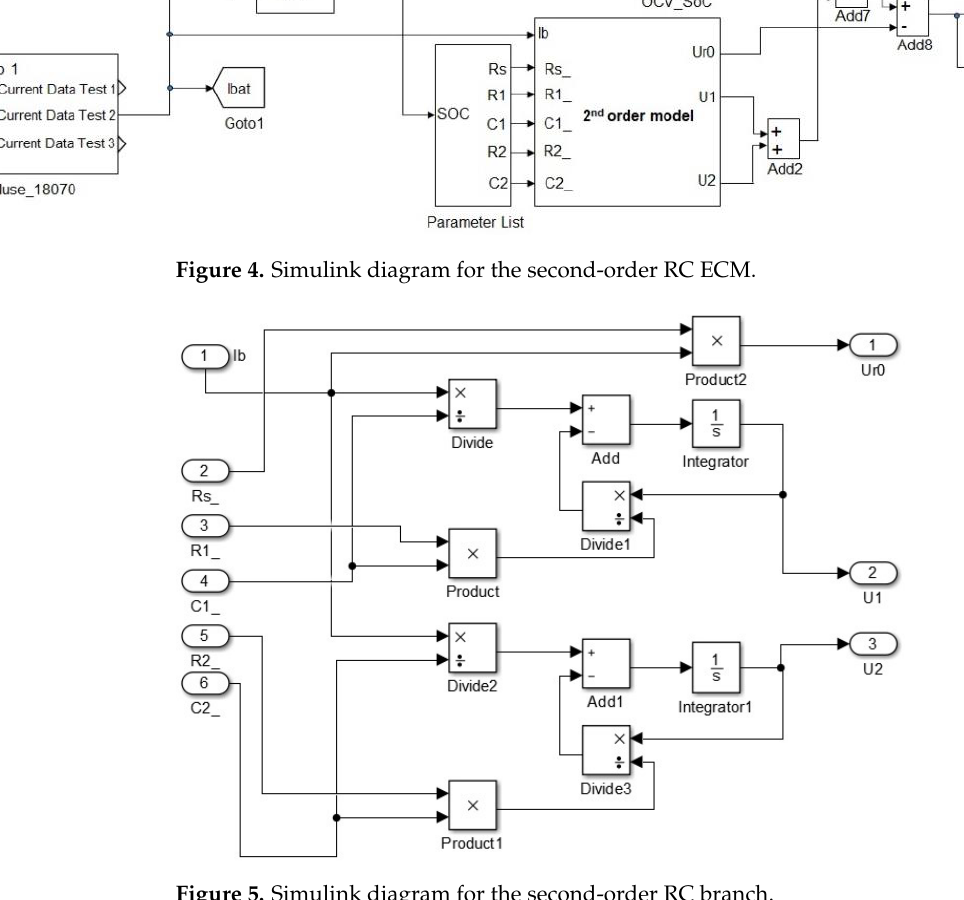
Figure 5. Simulink diagram for the second-order RC branch.